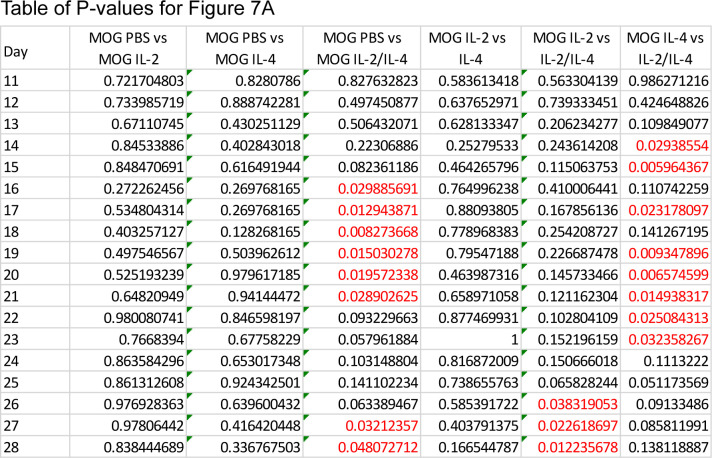
Combined IL-2 and IL-4 suppressed the severity of experimental autoimmune encephalomyelitis (EAE).Table of p-values for Figure 7A. Red font represents p≤0.05. Black font represents p>0.05. N = 10–12 for EAE mice, N = 4 for vehicle control mice. Related to Figure 7A.